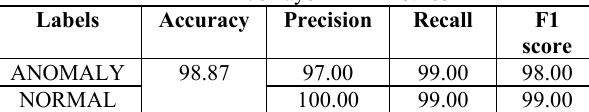
TABLE I. 3-layer MLP Metrics